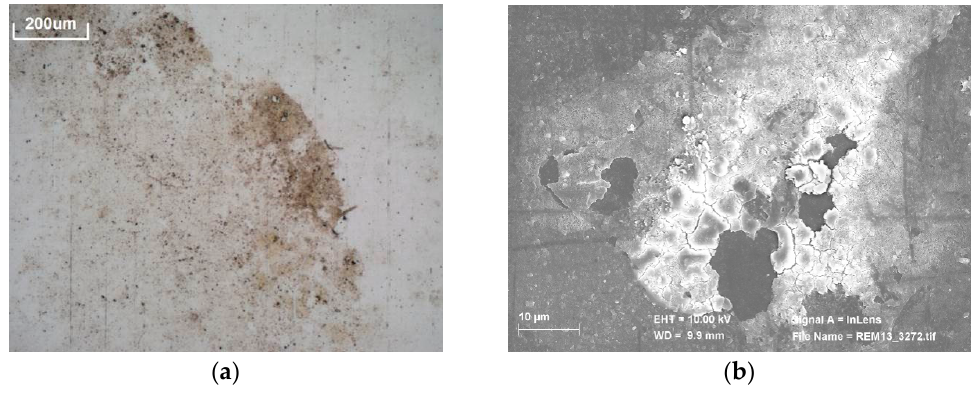
Figure 6. Microscopic ( a ) and SEM image ( b ) of deposits on the surface of material A.